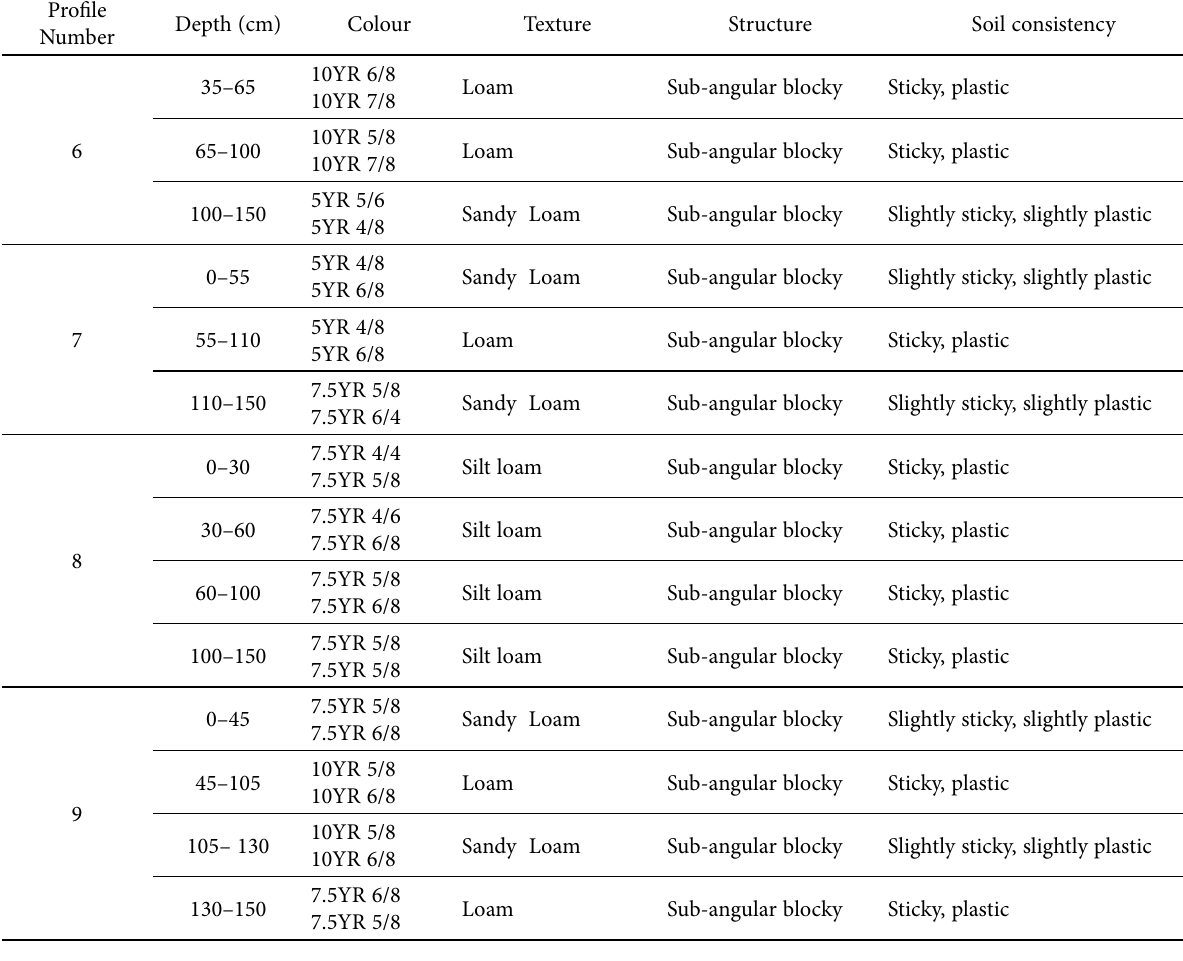
Table 3. Physiographic units on the soil map Physiographic